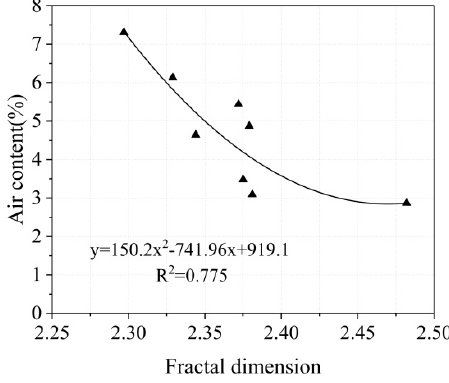
Figure 8. Fitting of air content and fractal dimension.